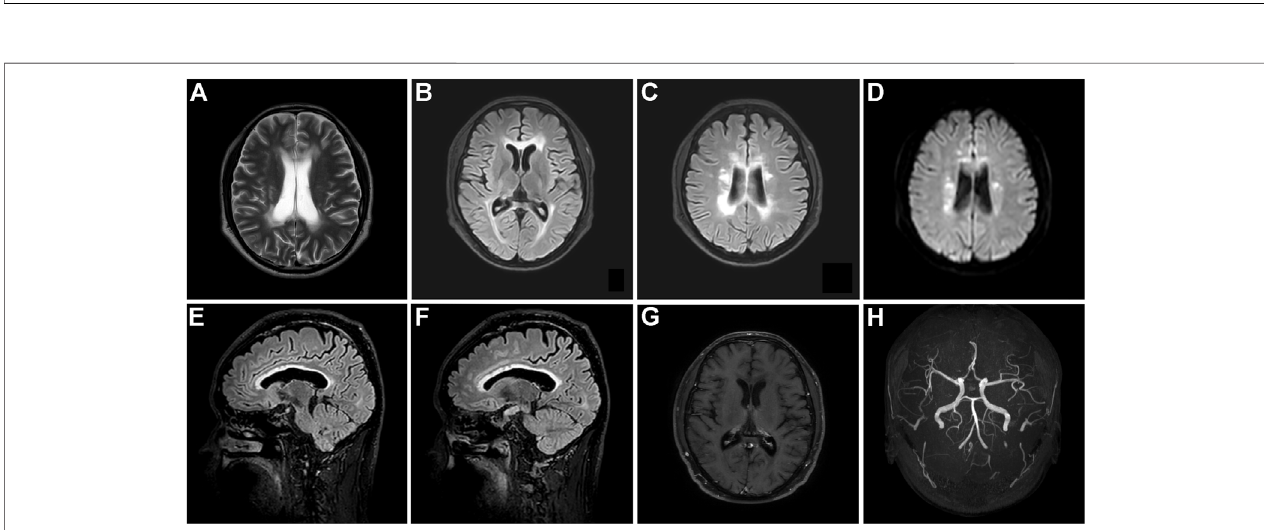
FIGURE 2 | Brain MRI of the proband with CSF1R-microglial encephalopathy in the fi rst family. Bilateral con fl uent and diffuse deep white matter hyperintensities involving periventricular areas, corona radiate and the corpus callosum, and moderate diffuse atrophy of the bilateral frontoparietal lobes can be seen on brain axial T2- weighted imaging (A) , fl uid-attenuated inversion recovery (FLAIR) (B,C) and diffusion-weighted imaging (D) . Sagittal brain FLAIR shows abnormal hyperintensities and thinning of the corpus callosum, and extensive cortical atrophy (E,F) . No obvious abnormalities can be found in the Gadolinium contrast-enhanced MRI (G) and cerebral arteries on magnetic resonance angiography (H)